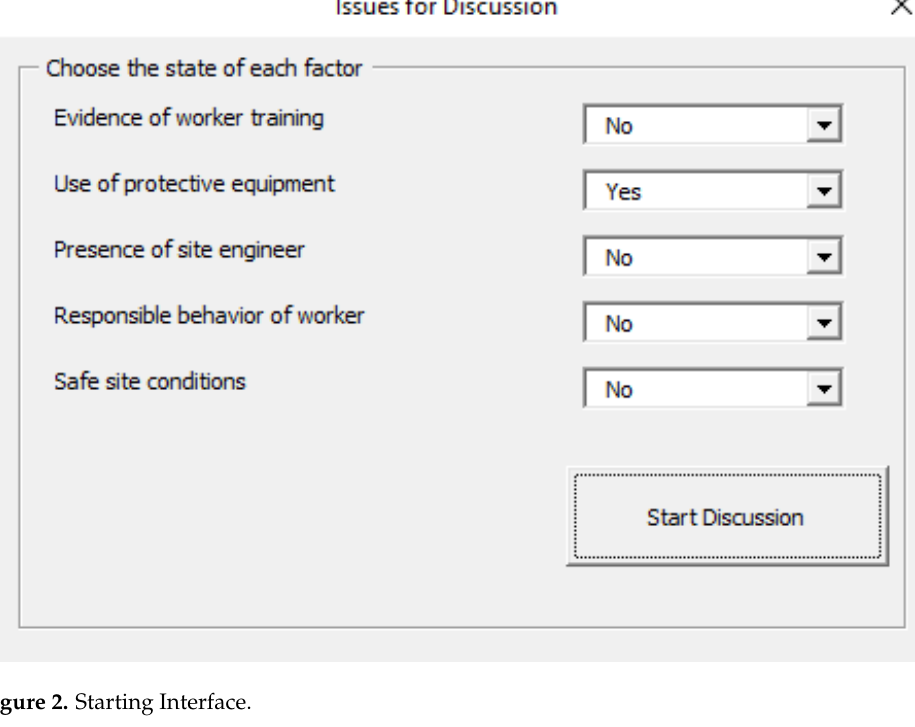
Figure 2. Starting Interface.